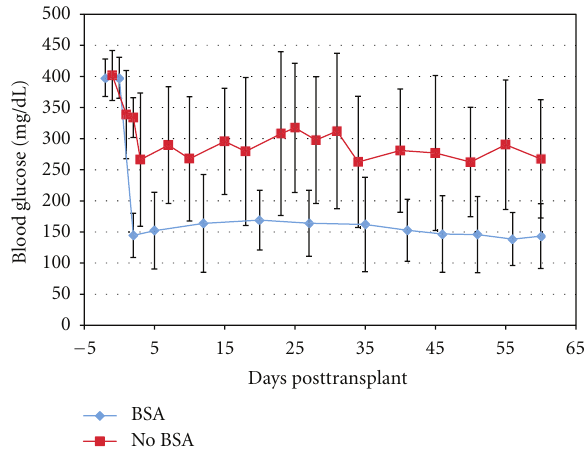
Figure 7: Glycemic levels in transplanted mice. Glycemic levels (mg/dL) of Streptozotocin treated mice were followed for 2 months after syngeneic transplant of 70 islets. Without BSA ( n = 11, squares); with BSA ( n = 18, diamonds). Transplant was performed on day 0. The di ff erence in average glycemia between the groups was statistically significant ( P -value 7.8 − 11